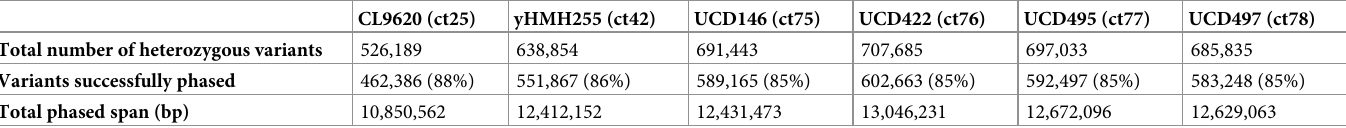
Table 1. Results of haplotype